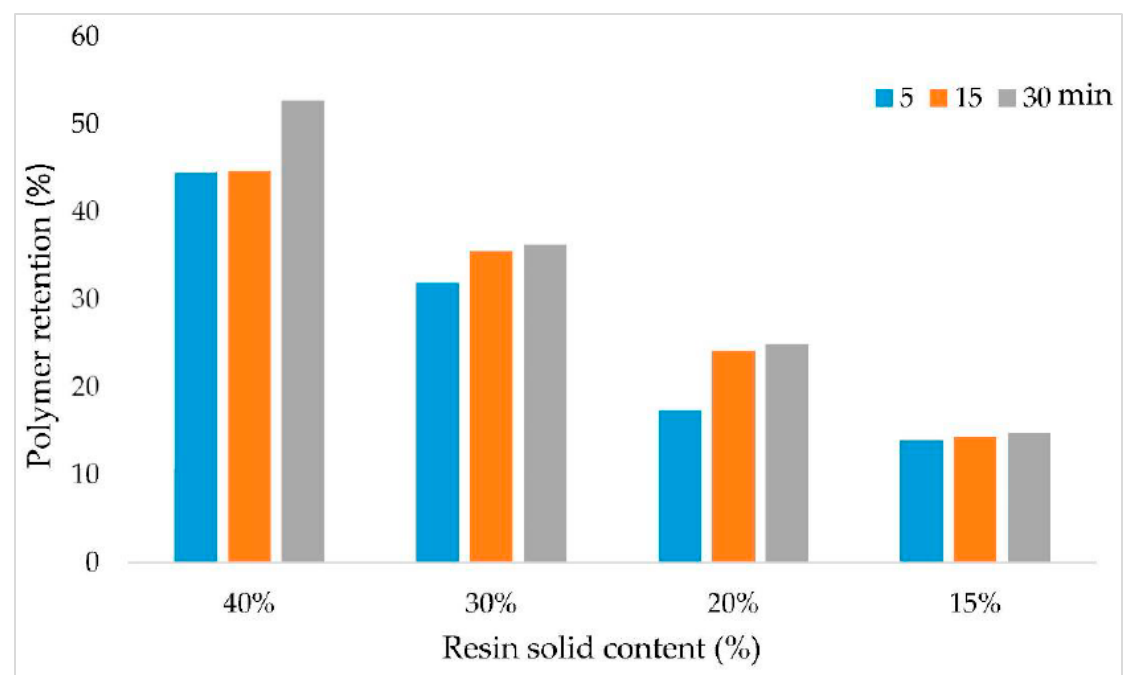
Figure 2. Polymer retention (PR) of OPT veneers as a function of resin solid content and soaking